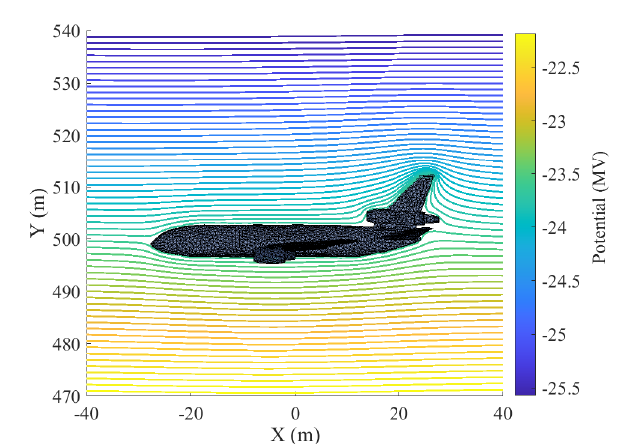
Figure 5. Equipotentials around DC-10 aircraft under uniform ambient